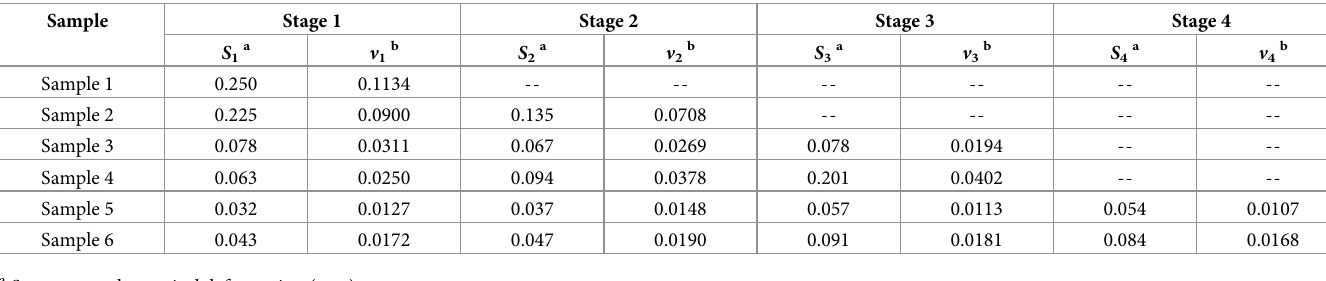
Table 4. Deformation and corresponding rate in the four reduction stages for each soil sample.